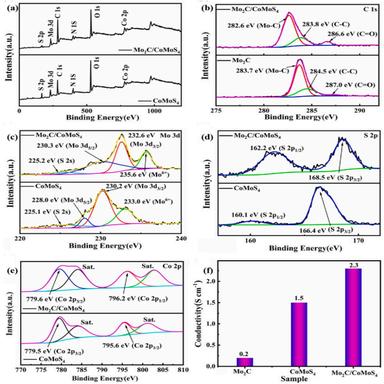
XPS survey of (a) CoMoS4 and Mo2C/CoMoS4, (b) C 1s, (c) Mo 3d, (d) S 2p, (e) Co 2p, and (f) spectra and conductivity of Mo2C, CoMoS4, and Mo2C/ CoMoS4.